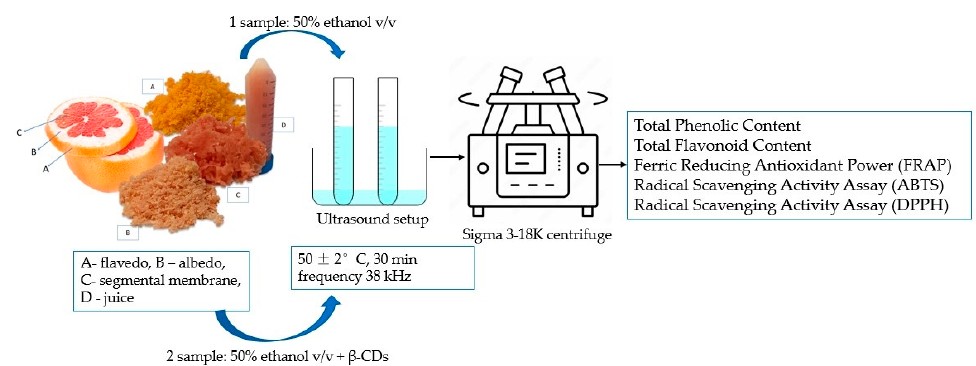
Figure 8. Extraction procedure to determine total phenolic, flavonoid, and antioxidant activity.